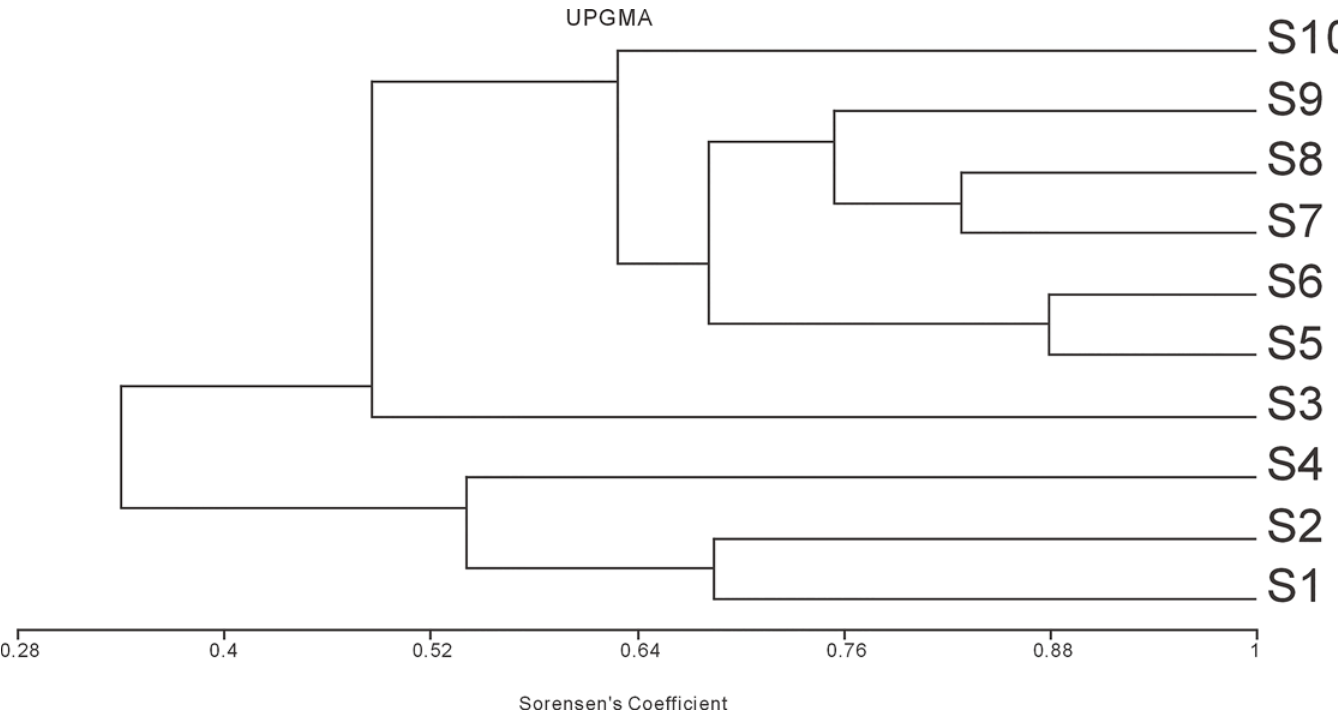
Fig 3. UPGMA dendrogram constructed with DGGE profiles of bacterial 16S rDNA PCR amplification products from rhizosphere soil samples S1-S10. Soil samples were labeled as Table 2. S1, CK1-Single peanut, S2, CK2-Single buckwheat, S3, CK3-Single sorghum, S4,CK4-Single glutinous millet, S5, Intercropping buckwheat(/peanut), S6, Intercropping peanut(/buckwheat), S7, Intercropping glutinous millet(/peanut), S8, Intercropping peanut (/glutinous millet), S9, Intercropping peanut(/foxtail millet), S10, Intercropping sorghum(/peanut).